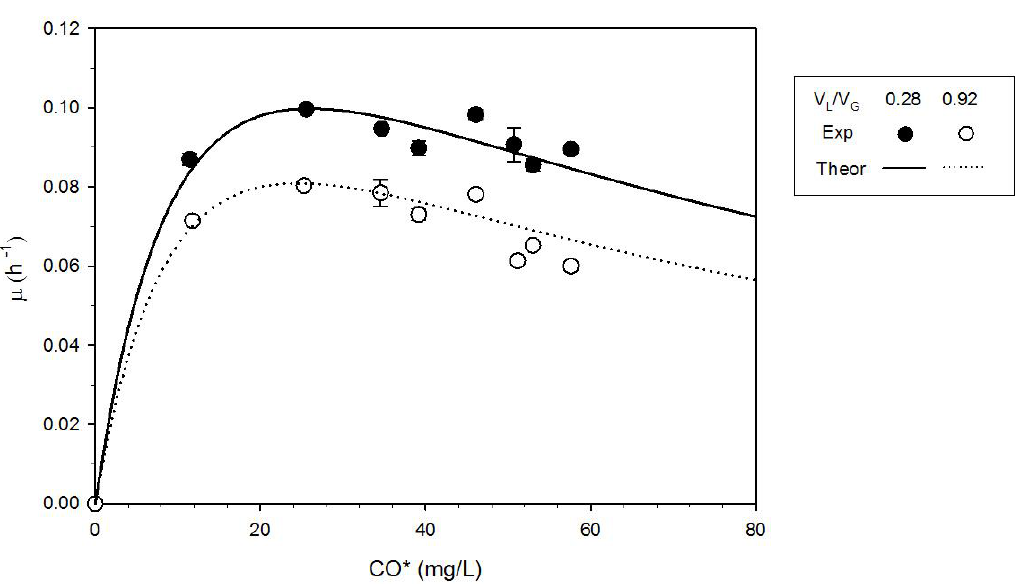
Figure 2. Specific cell growth rate of C. carboxivorans as a function of initial CO concentration in the liquid phase—it was assumed that at the beginning of the fermentation the CO in the liquid phase (CO*) was under equilibrium conditions with the gas phase. Lines are the plot of Equation (1) (parameters in Table 3).